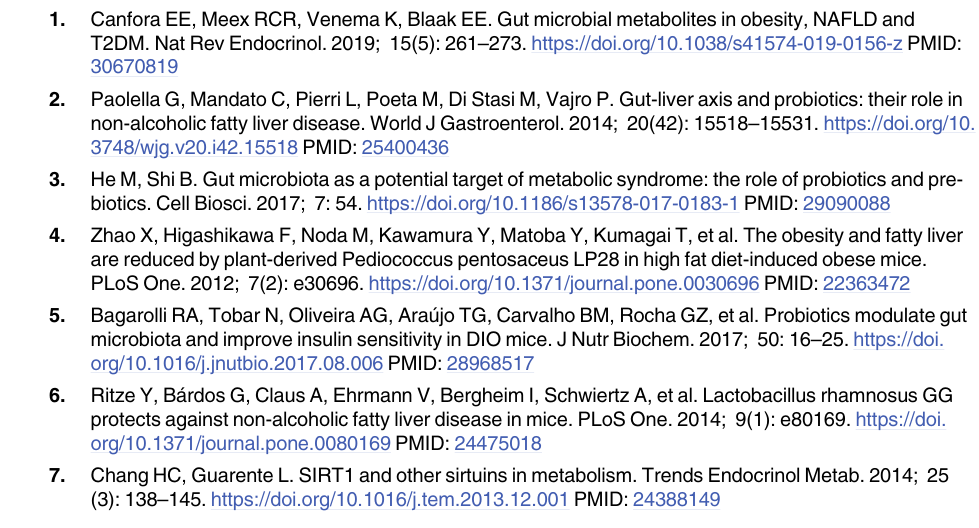
S2 Fig. Raw images of Fig 2K. S1 Table. Composition of the normal diet and high-fat diet. S2 Table. Primer sequences for real-time